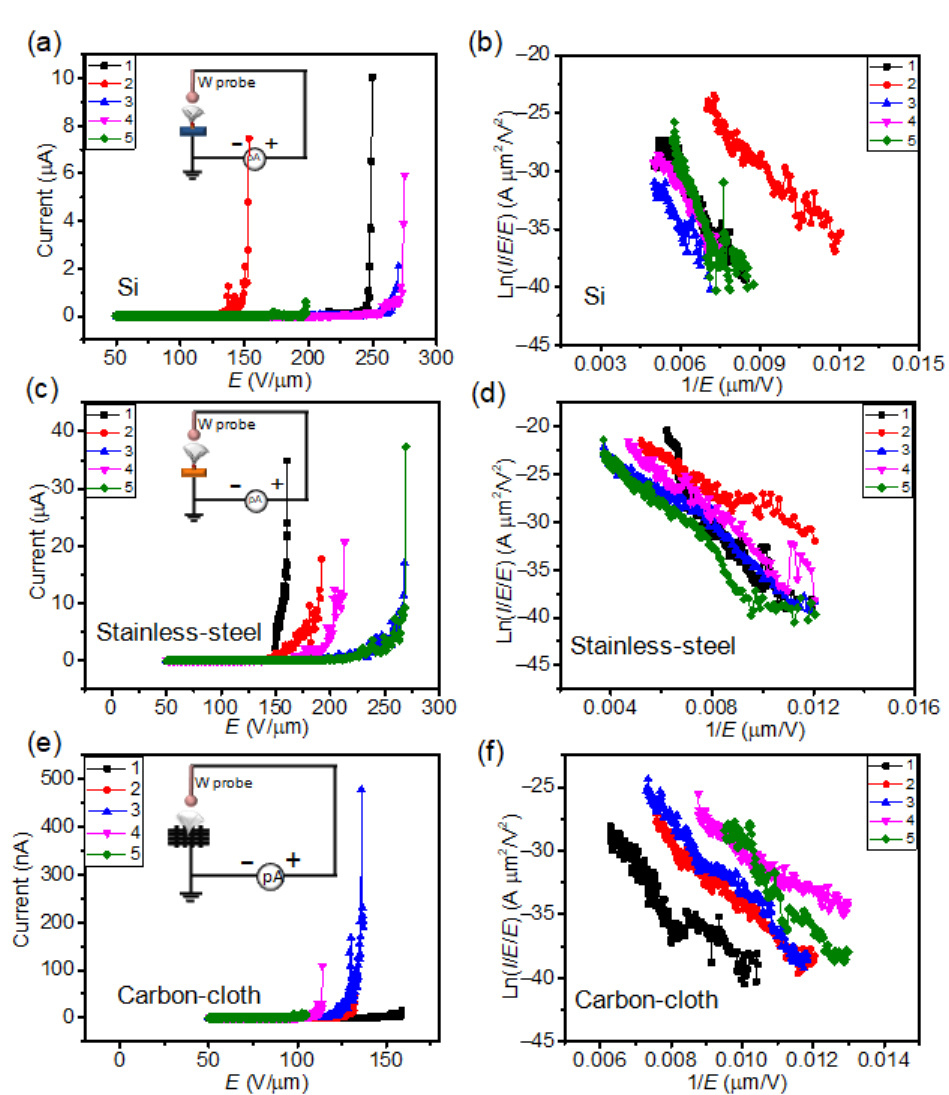
Figure 7. Field emission properties of single VFLGs grown on different substrates. Field emission I - V curves and F - N curves of five randomly selected single VFLGs on ( a , b ) Si substrates, ( c , d ) stainless-steel substrates, ( e , f ) flexible carbon-cloth substrate. Inserts are the circuits diagrams of the field emission test. All tests were carried out in DC voltage mode. Table 3. Comparison of the high emission current/current density/breakdown voltage of the re- ported single sheet/wire/tube nanomaterials.